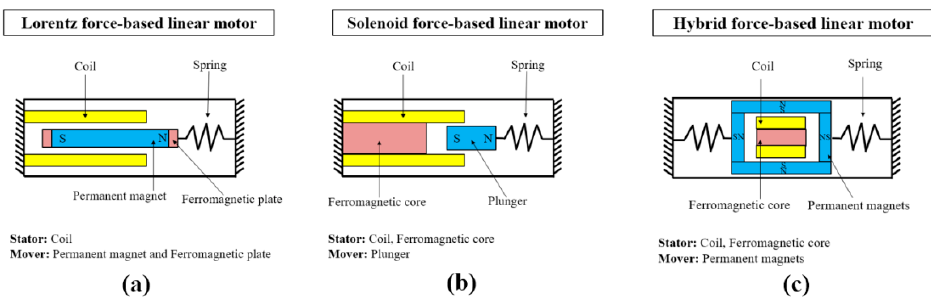
Figure 2. Typical structures of linear motors based on the type of force: ( a ) Lorentz force-based linear motor; ( b ) solenoid force-based linear motor; ( c ) hybrid force-based linear motor.